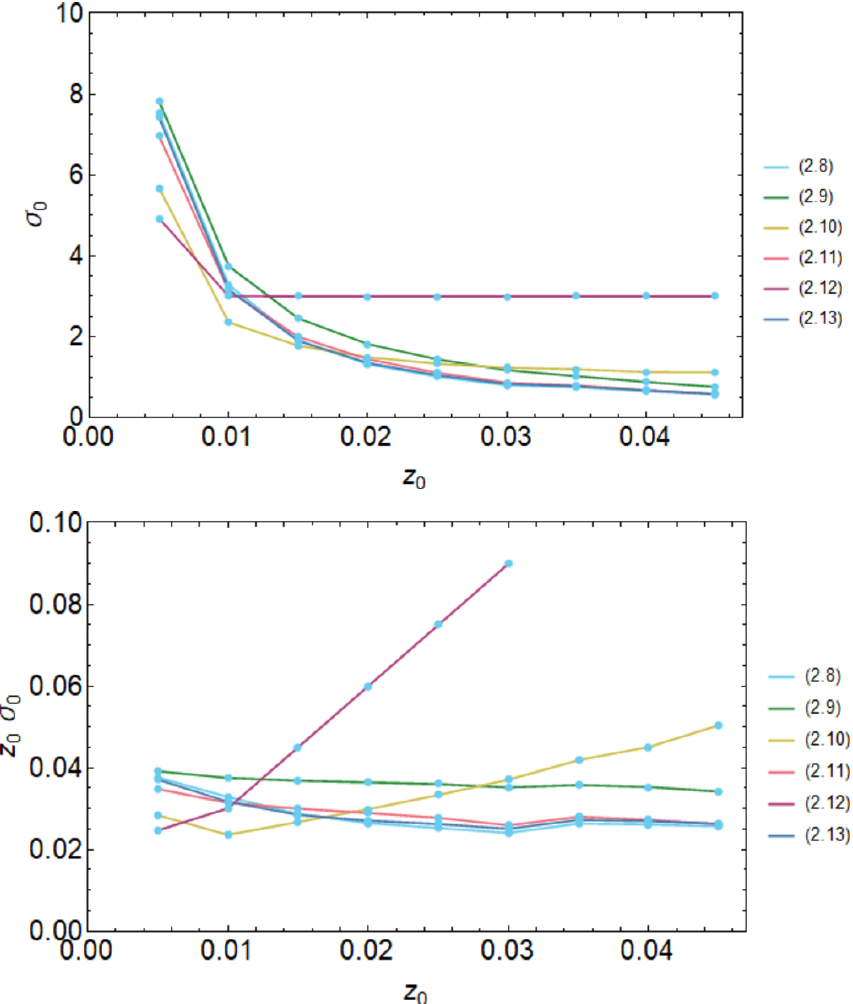
Figure 4 . For each of the six classes of initial conditions in eqs. (2.8){(2.13), we plot the downward angle (cid:27) 0 reached by the endpoint of the string after it nulli(cid:12)es, which is to say after the downward angle no longer changes. In the upper panel, we show how (cid:27) 0 varies as we change the AdS depth z 0 at which we initialize the string, while keeping the energy of the string (cid:12)xed. We (cid:12)nd that for strings with the initial conditions (2.8), (2.9), (2.11) and (2.13) in which the downward angle of the string endpoint is initially zero, to a good approximation the opening angle (cid:27) 0 reached by the string endpoint after nulli(cid:12)cation is given by (cid:27) 0 (cid:24) 1 , with a prefactor c that depends weakly on the E z 0 initial string pro(cid:12)le. For the initial conditions (2.10) and (2.12) in which the downward angle of the string endpoint is initially nonzero and in which the strings are closer to null from the beginning, this relationship is not